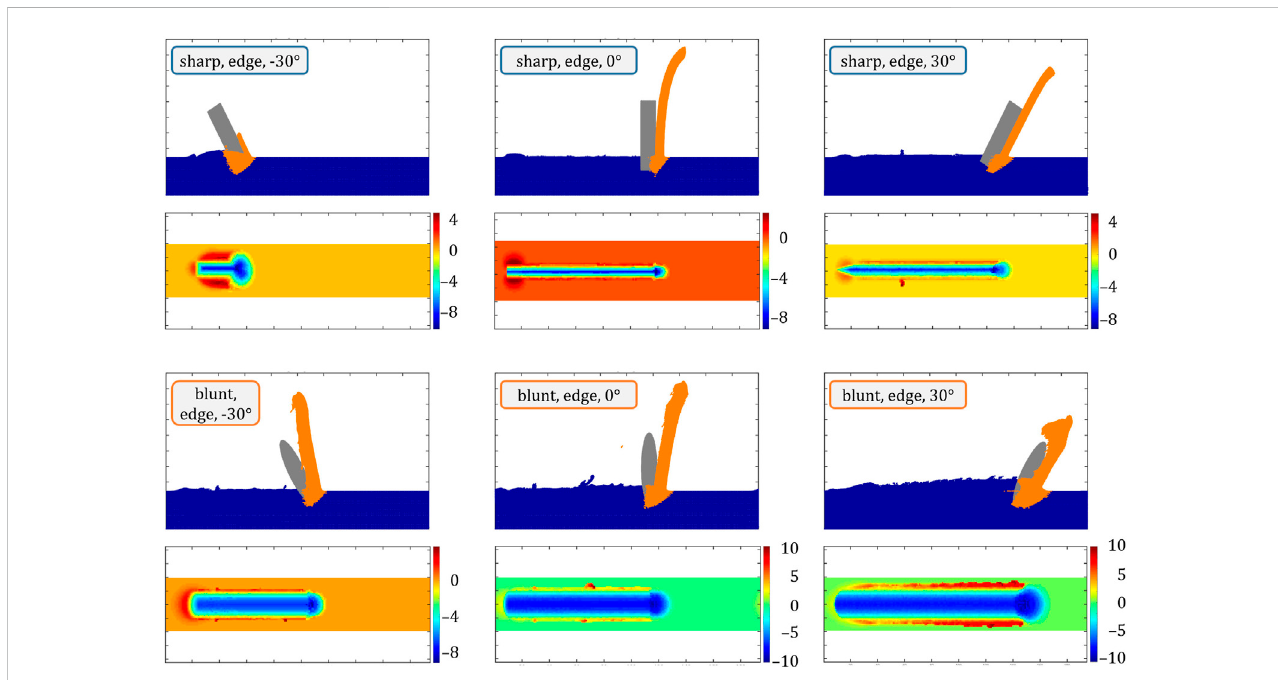
FIGURE 2 Rakeangleandabrasiveshapedependenceofchipformation andmorphology aswellas workpiecetopography at8 μ minfeeddepth. Thecolorbarsof the topographic maps are in μ m.